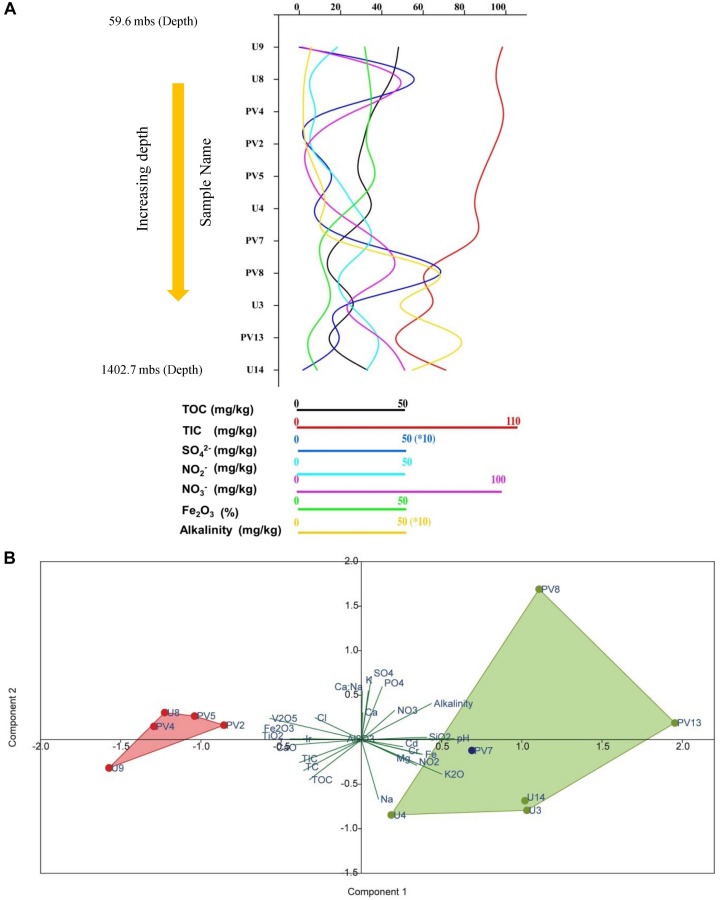
Distribution of different geochemical parameters and archaeal population across different samples of subterranean Deccan traps. (A) Variations of different geochemical parameters across samples. (B) Principal component analysis (PCA) of geochemical parameters of subsurface rock cores of Koyna–Warna region; Green dots represent samples from the granitic horizon, red circles represent samples from the basaltic horizon and blue dot represents sample from the transition zone. mbs – meters below surface.